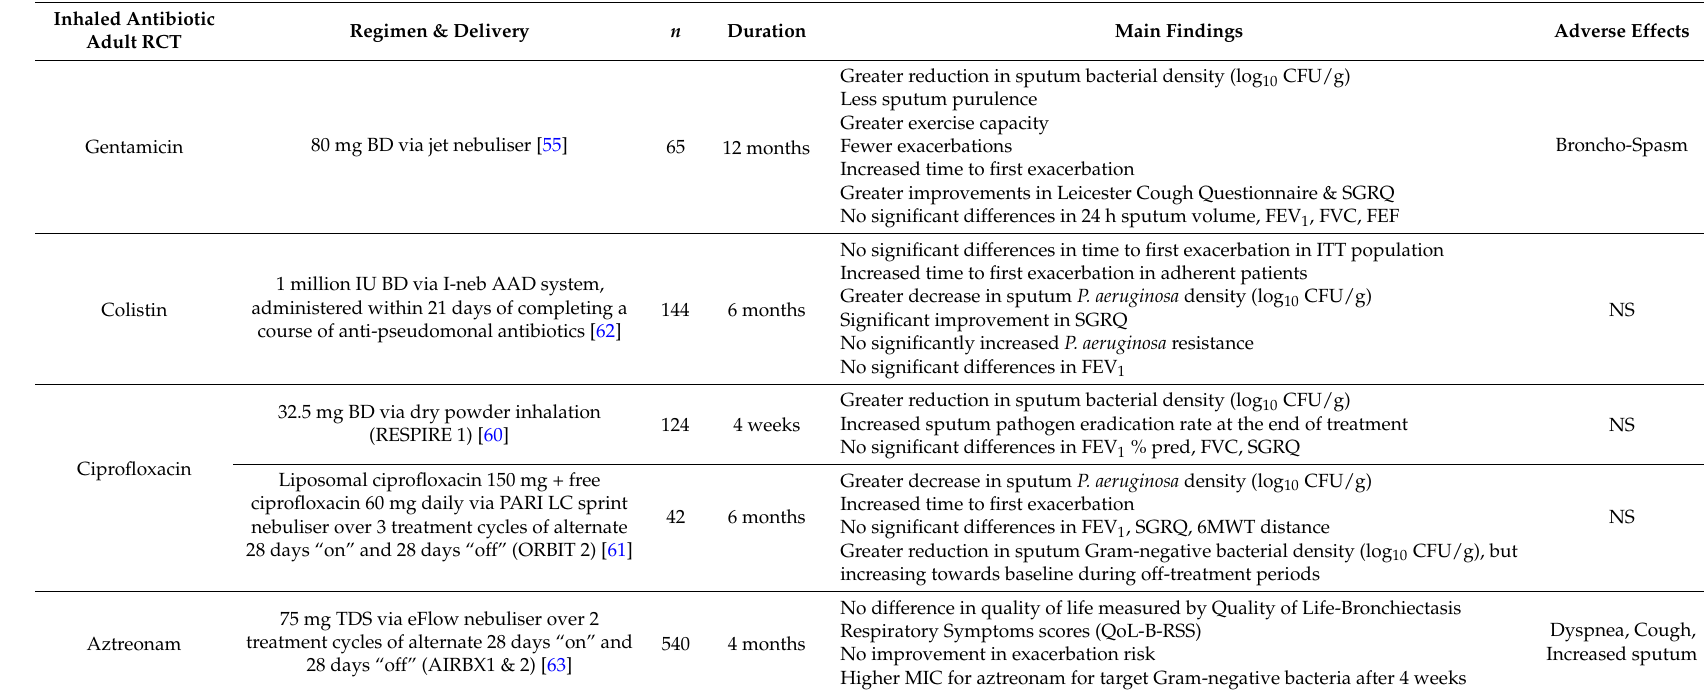
Table 3. Key recent inhaled antibiotic adult RCTs in